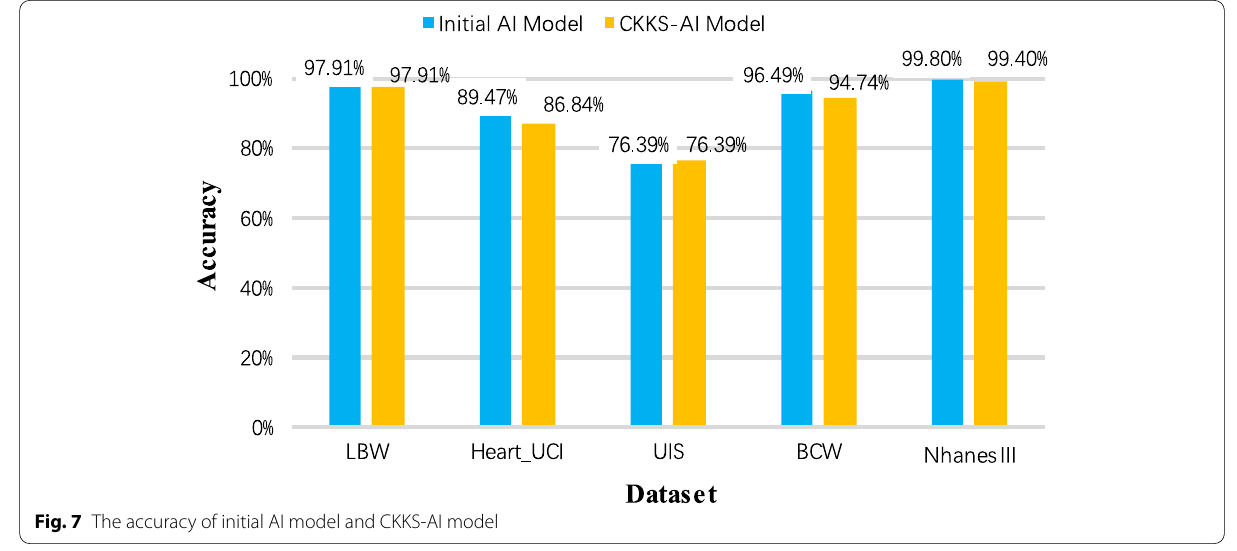
Fig. 7 The accuracy of initial AI model and CKKS-AI model